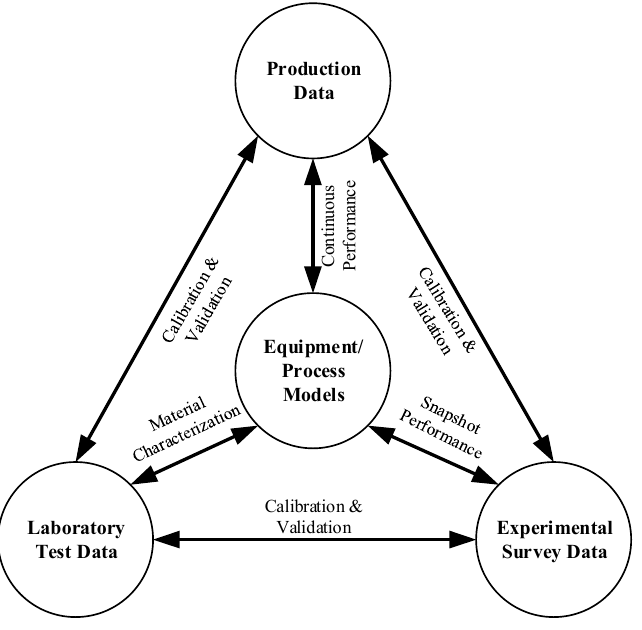
Figure 2. Generalized view on the model and process calibration based on the sources of data.